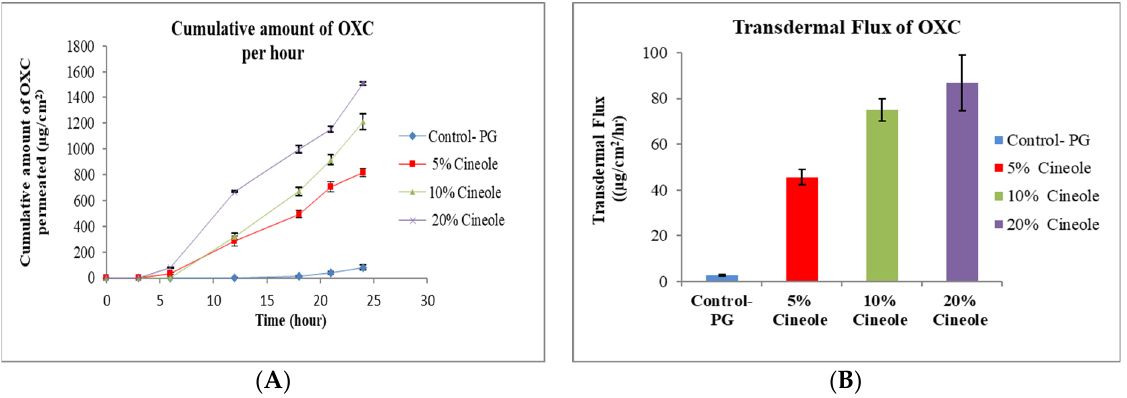
Figure 4. In vitro cumulative amount of OXC permeated per unit area versus time ( A ) and transdermal flux of OXC ( B ) across the human cadaver skin in presence or absence of cineole. Each point represents the mean ± S.D. of three replicates in the absence of multiple donors.